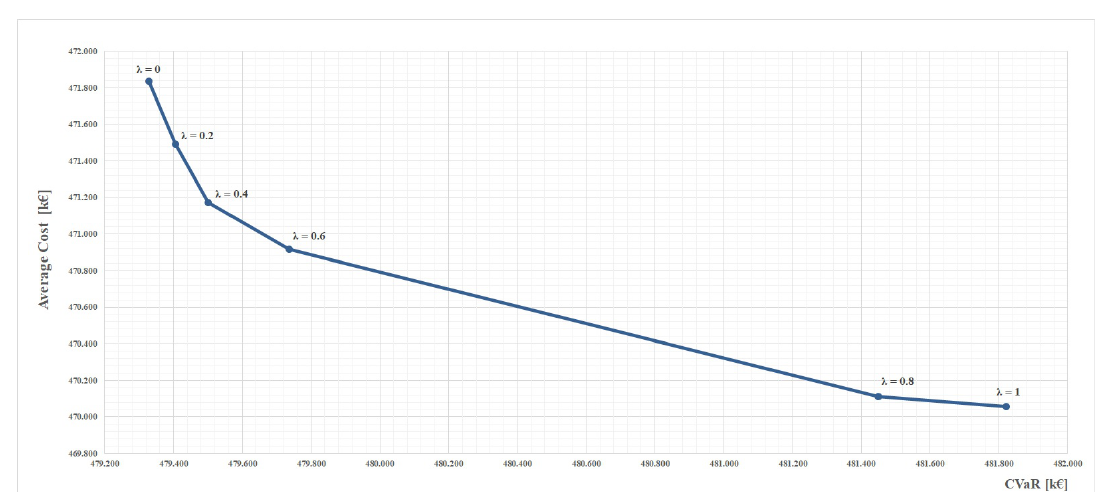
Figure 6. Trade-off between expected cost and